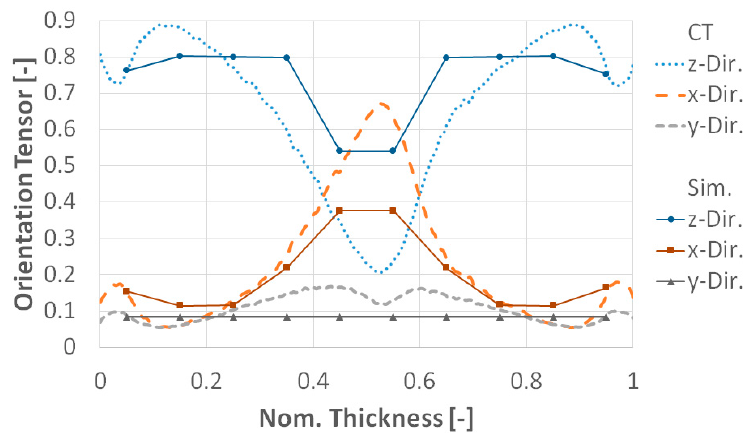
Figure 14. Fiber orientation tensors of the measured (CT) and calculated (Sim.) PPA ‐ GF50 specimens.